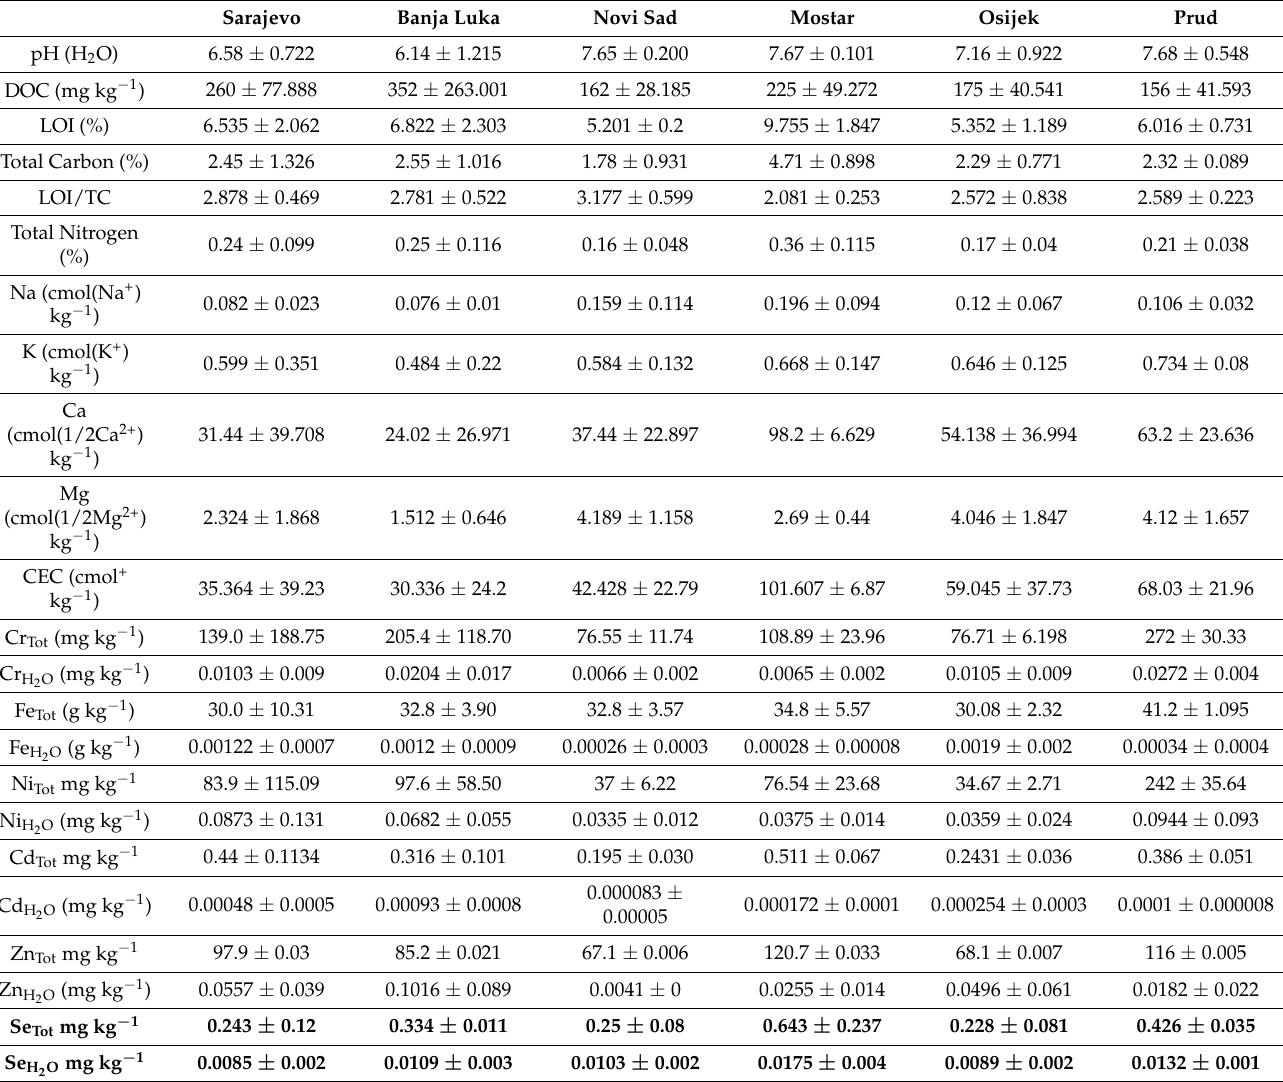
Table 1. The table shows mean values including ± standard deviation (SD) of important soil parameters measured in soils from Sarajevo, Banja Luka, Novi Sad, Mostar, Prud, and Osijek ( n = 52). Sarajevo Banja Luka Novi Sad Mostar